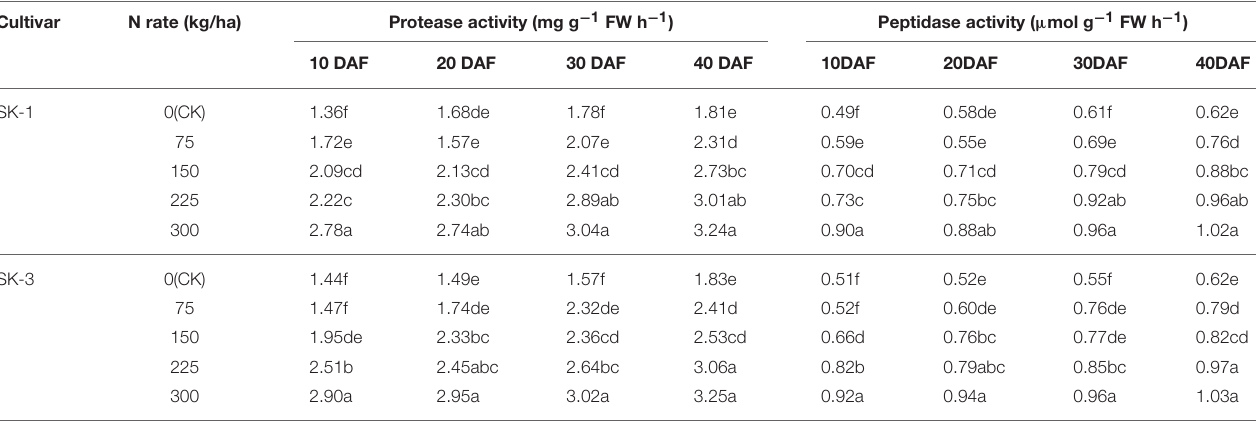
TABLE 10 | The effect of the nitrogen level on the boll shell protease and peptidase activities of the two Bt cotton cultivars in 2016.